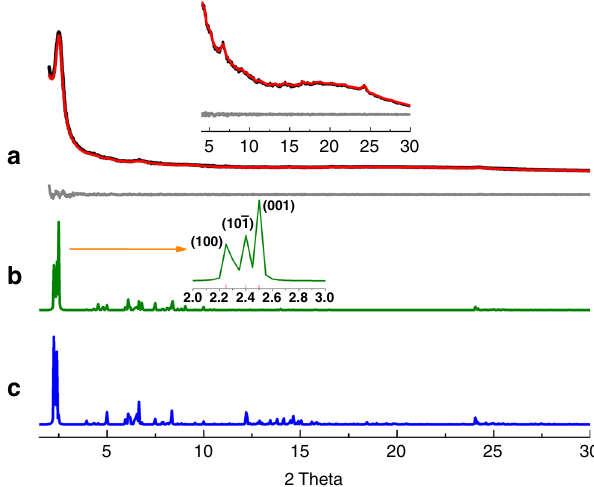
Fig. 3 PXRD pro fi les of Tetra-COF-DAB . a Experimental (black) and Pawley re fi ned (red) PXRD patterns and difference plot (gray) between them, b simulated PXRD patterns with AA stacking, and c AB stacking